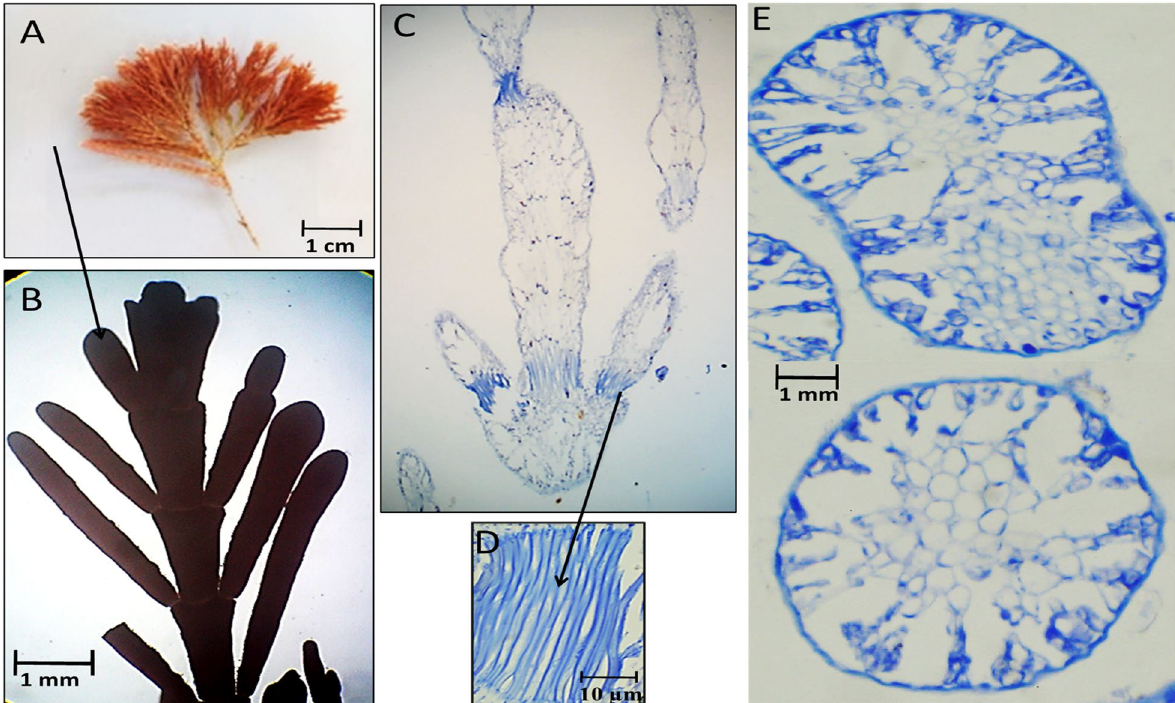
Fig. 4 Morphological and anatomical description of C. officinalis thallus during spring 2020. A Habit view of thallus, B Magnification of the thallus frond, C L. S. in thallus showing genicula and intergenicula tiers, D Magnification of mature geniculum, E) Cross-section through